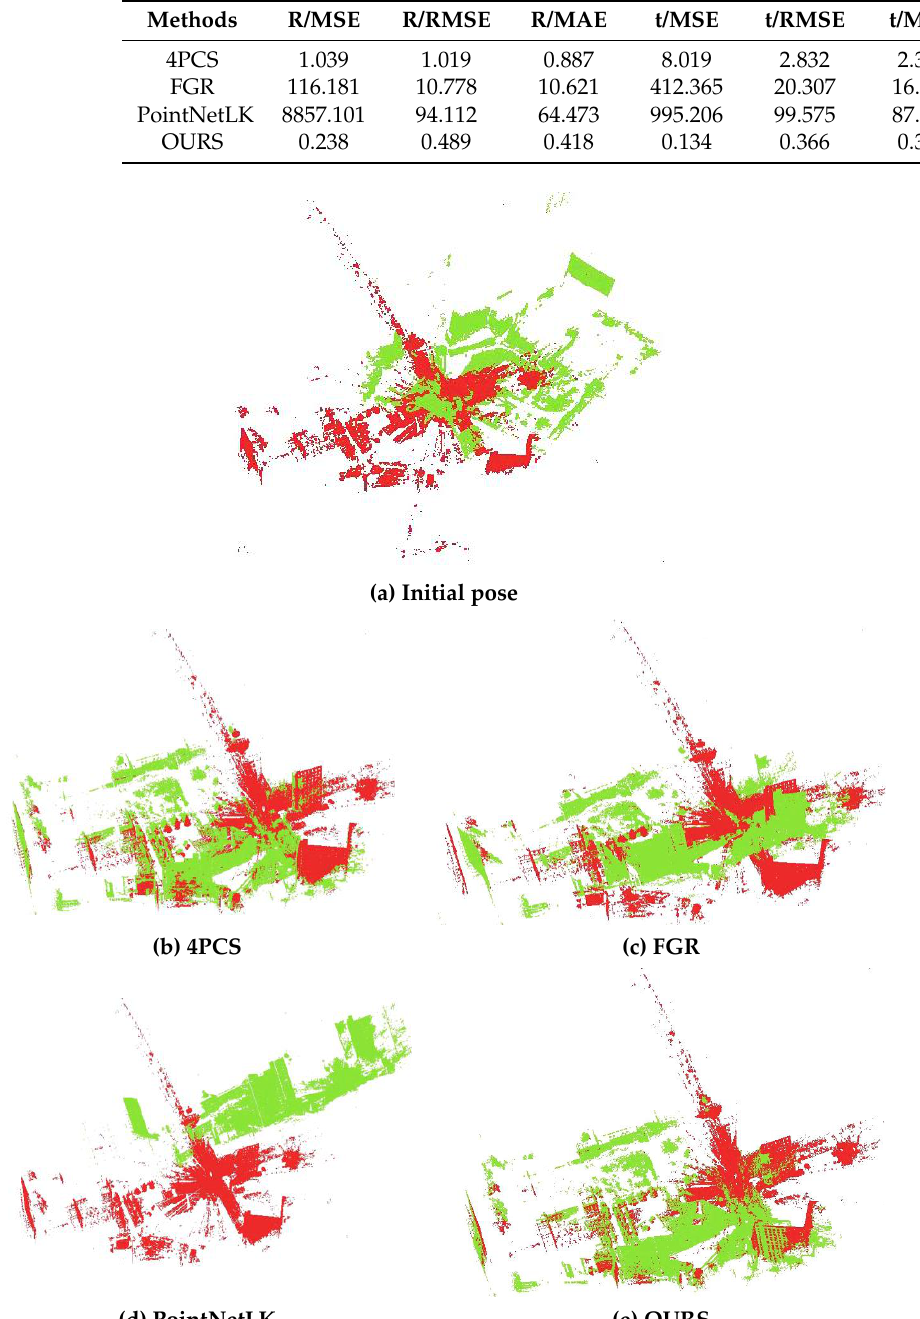
Figure 4. Each line shows registration error and time cost with respect to the maximum number of iterations, (a) Our method, (b) Traditional RANSAC method.